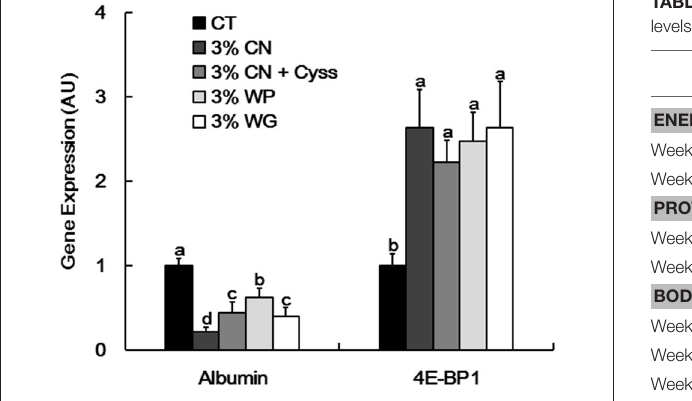
FIGURE 4 | Hepatic albumin and 4E-BP1 gene expression in Experiment 1. Gene expression of albumin and eukaryotic initiation factor 4E-binding protein 1 (4E-BP1) was determined in livers obtained at the end of the experimental period. Data are shown as means ± SD ( n = 6), and values with different letters are significantly different ( P < 0.05). CN, CT, Cyss, WG, and WP denote casein, control, cystine, wheat gluten, and whey protein, respectively.